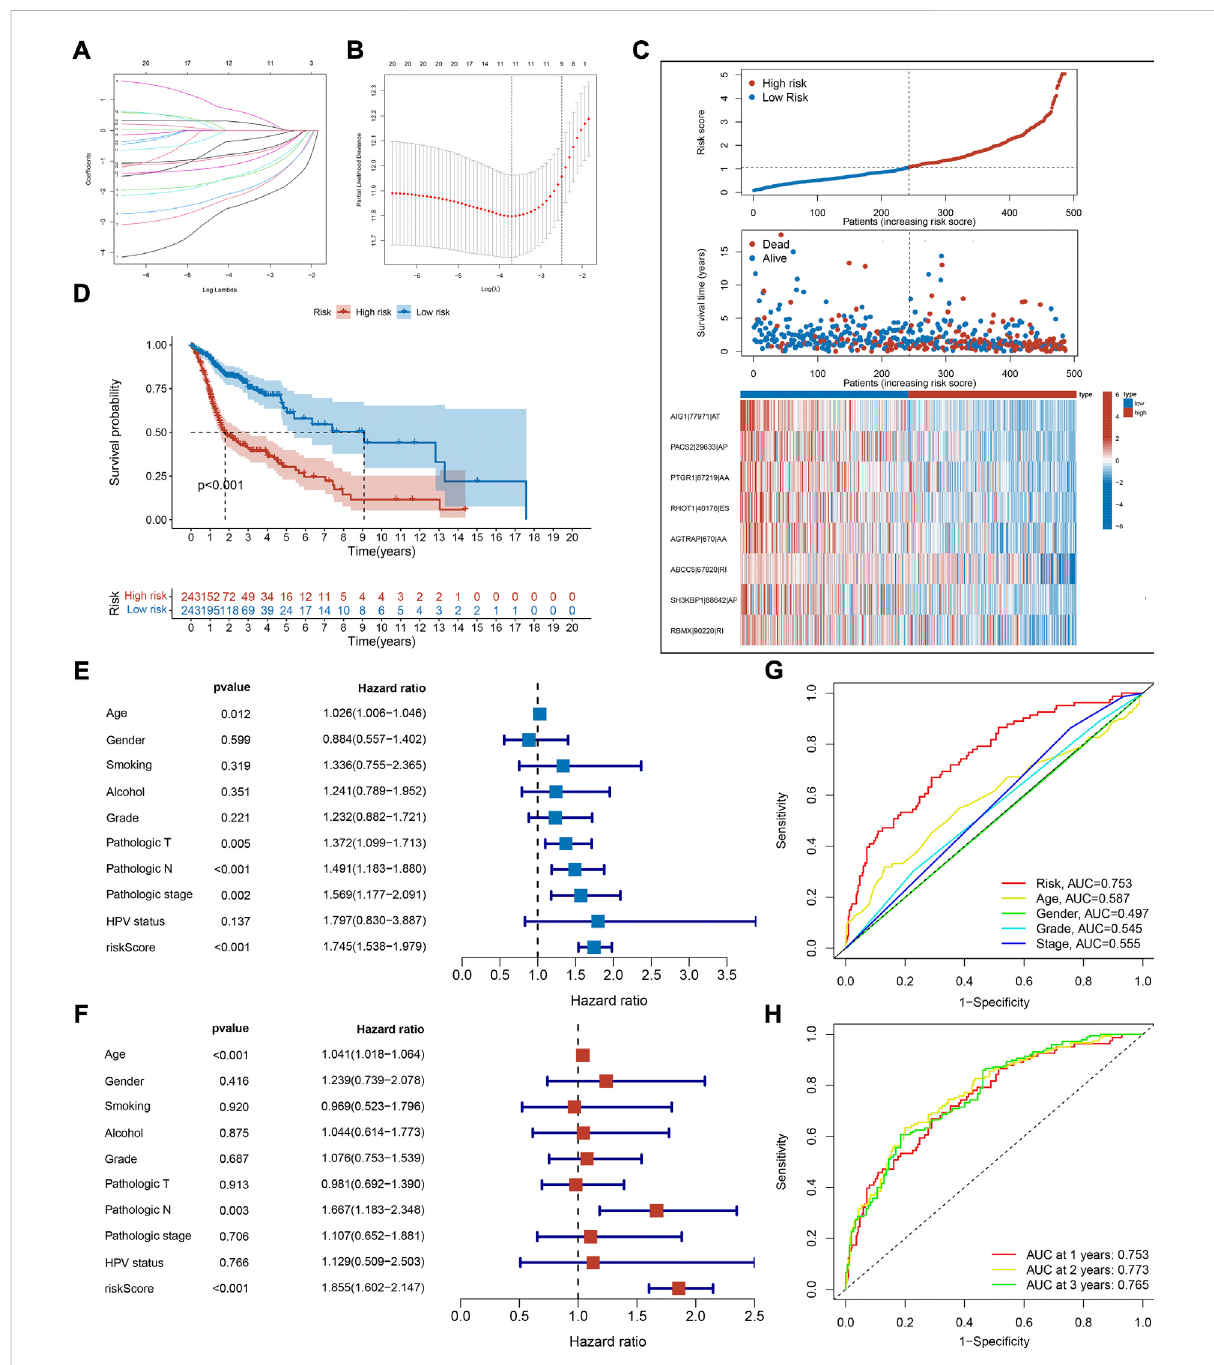
FIGURE 3 Construction and evaluation of prognostic signature. (A) Distribution of LASSO regression coef fi cients for survival-associated AS events. (B) Shrinkage parameter selection in the LASSO model used ten fold cross-validation via minimum criteria. Vertical dotted lines were drawn at the optimum λ values. (C) The risk score distribution, overall survival status, and expression pro fi le of selected AS events of each HNSC sample. (D) Kaplan-Meier survival curve of overall survival. Log-rank test was used for data analysis. (E,F) Forest plots of hazard ratios (HRs) calculated by univariate (E) and multivariate (F) Cox regression for risk score and clinical features associated with overall survival. (G) Receiver operating characteristic (ROC) curve and the area under the curve (AUC) of risk score and clinical features in predictive performance for HNSC patients. (H) ROC plots and AUC of the risk score at 1, 2, and 3